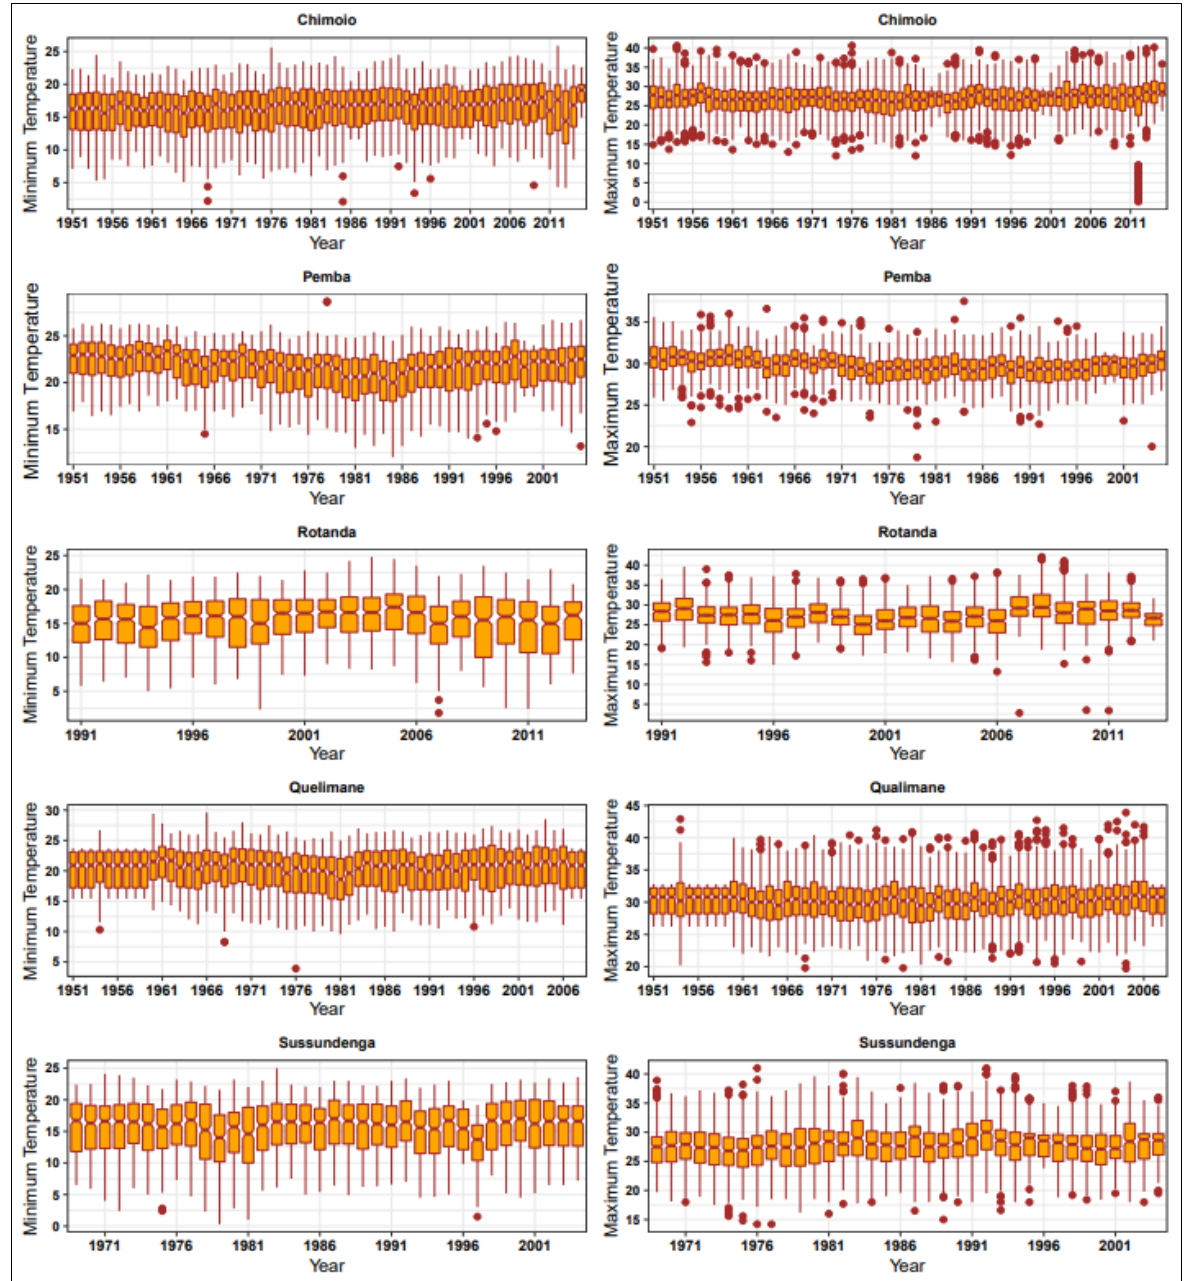
Figure 3. Minimum and maximum temperature trends at five locations in Mozambique over varying periods between 1951 and 2014.